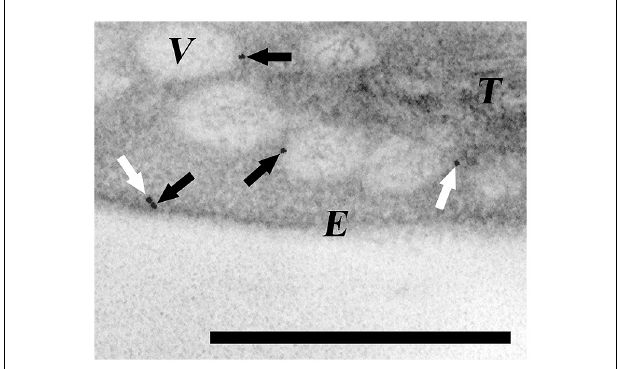
FIGURE 1 | Detection of CPSAR1 in Arabidopsis chloroplasts. Transmission electron micrograph of immunogold-labeled sections of leaves after low temperature incubation (Garcia etal., 2010) showing the presence of CPSAR1 in the stroma (white arrow) and at both the envelope and vesicle membranes (black arrows). E, envelope;V, vesicle;T, thylakoids. Bar 0.5 μ